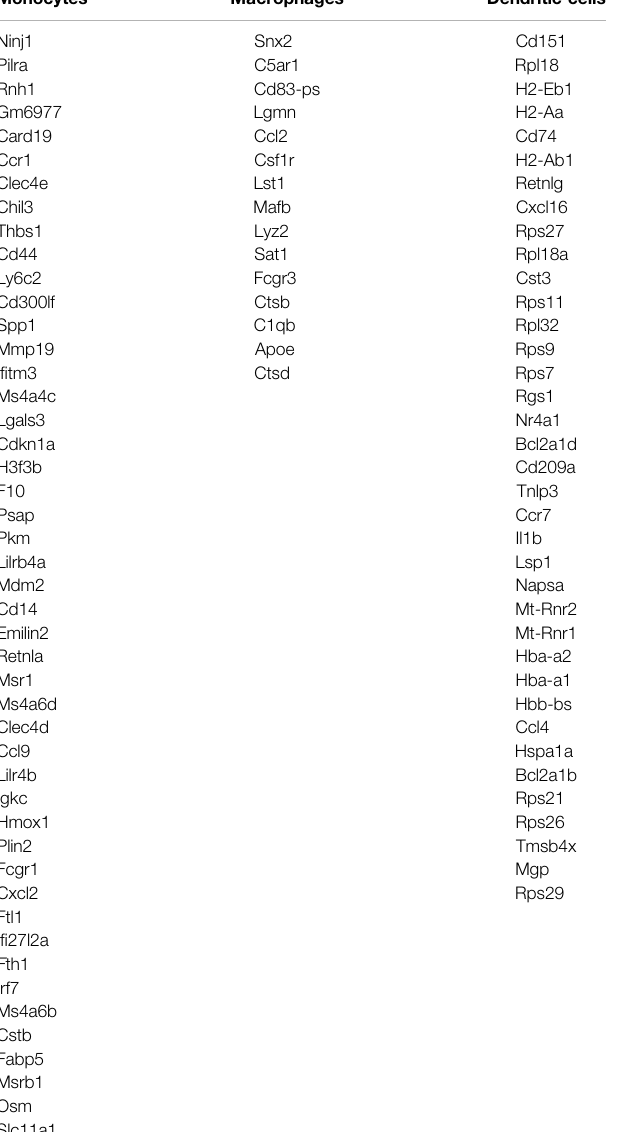
TABLE 2 | Signi fi cant branch-dependent genes of the mononuclear phagocyte system in two mice uteri. Monocytes Macrophages Dendritic cells